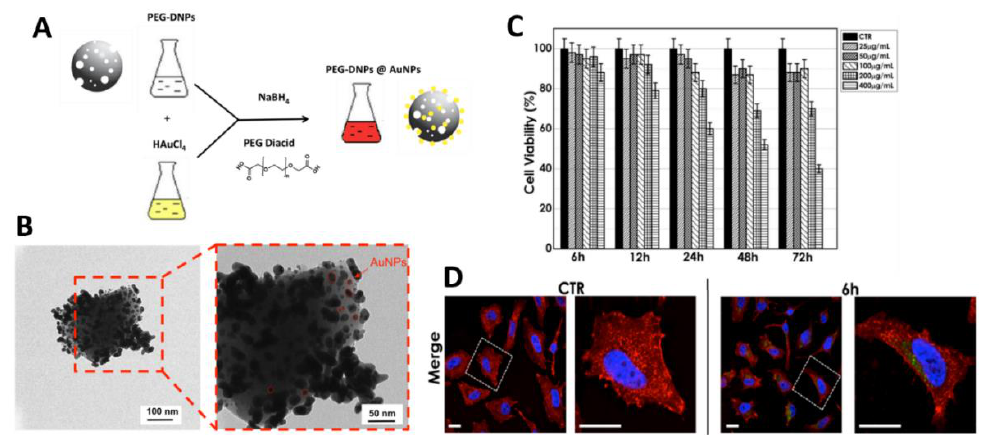
Figure 7. ( A ) Scheme of one-pot liquid phase synthesis method used for decorating diatomite NPs’ surface with gold NPs (PEG-DNPs@AuNPs). ( B ) TEM images of hybrid PEG-DNPs@AuNPs. ( C ) Cell viability of HeLa cells after exposure to 25, 50, 100, 200, and 400 µ g/mL of the PEG-DNPs@AuNPs for 6, 12, 24, 48, and 72 h at 37 ◦ C. ( D ) Representative confocal microscopy image of PEG-DNPs@AuNPs (100 µ g/mL) labelled with Alexa Fluor ® 488 (green) internalized into HeLa cells at 6 h. Cell nuclei and membranes were stained with Hoechst (blue) and WGA-Alexa Fluor ® 555 (red), respectively. Adapted with permission from [75], IOPscience, 2018.